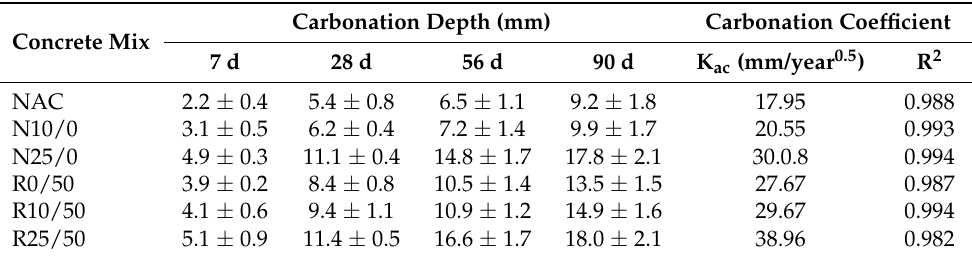
Table 6. Carbonation depth and coefficients in concrete mixes with 7 d, 28 d, 56 d or 90 d exposure to accelerated carbonation ( ± , standard deviation).